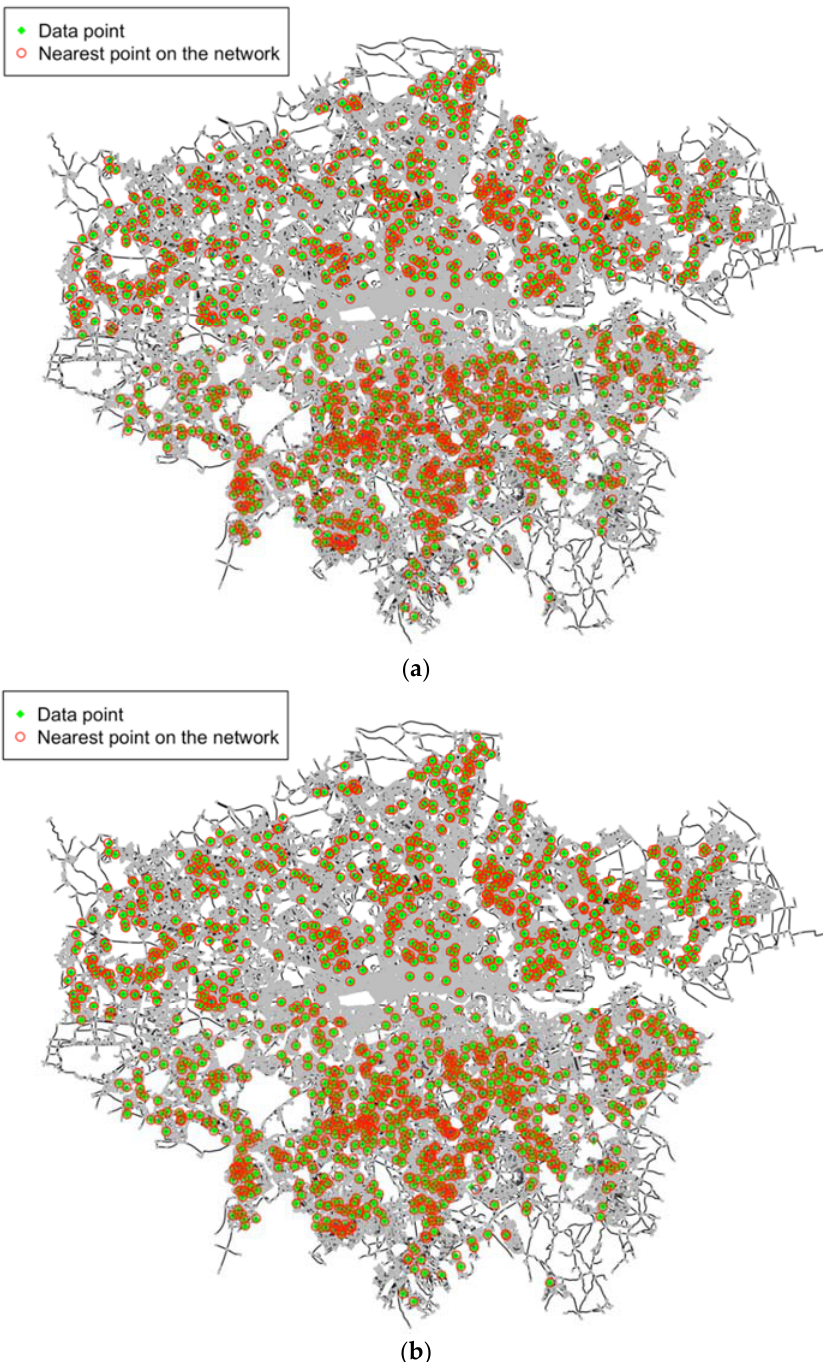
Figure 11. Integration of the London property locations onto the London road network using strategies 1 and 2. ( a ) Solution with strategy 1; ( b ) Solution with strategy 2.